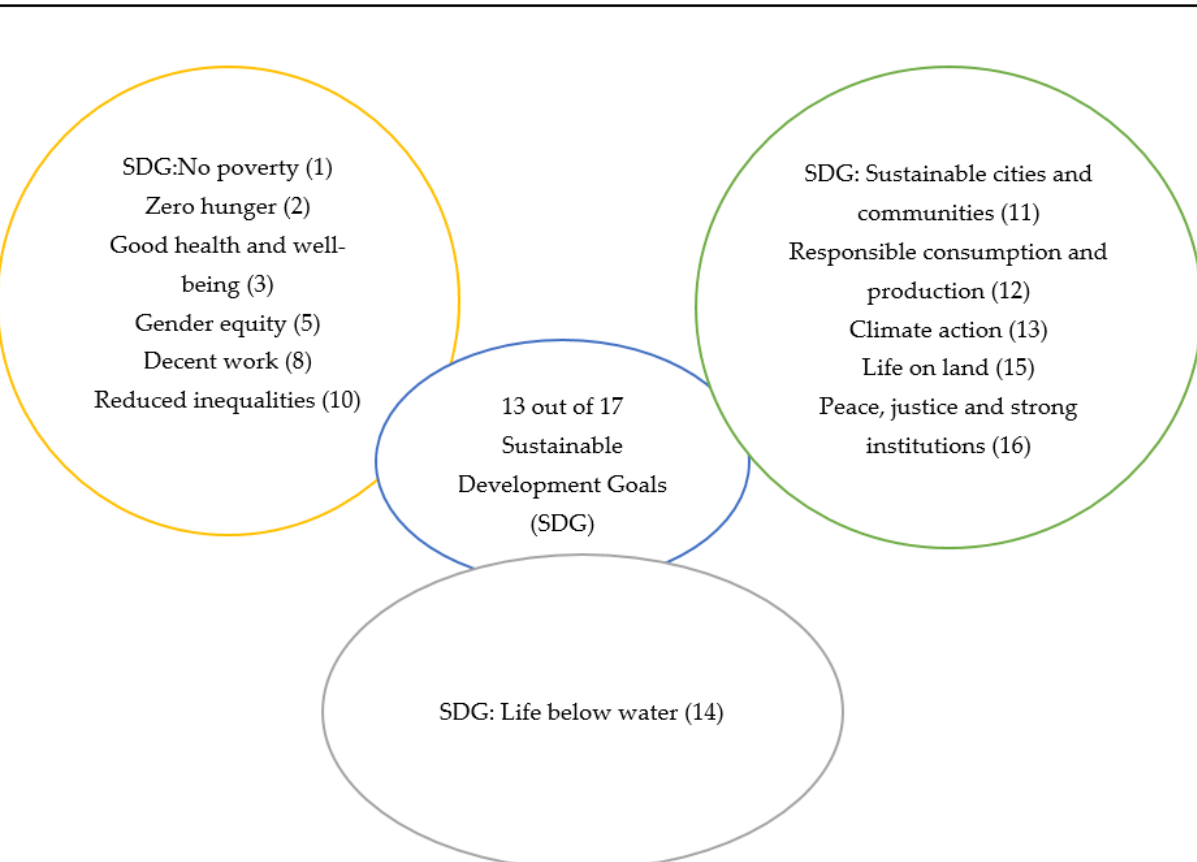
Figure 1. Schematic presentation of the 13 out of 17 SDGs aligned with edible